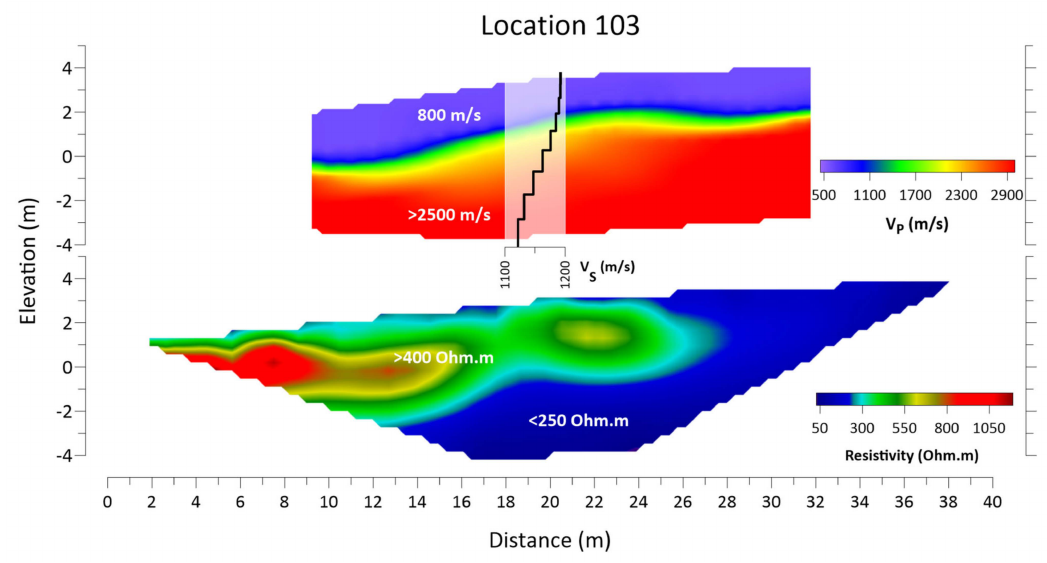
Figure 7. SRT and MASW ( top ) and ERT ( bottom ) at location 103, investigating the Viglae limestone ( Js Ks k ).